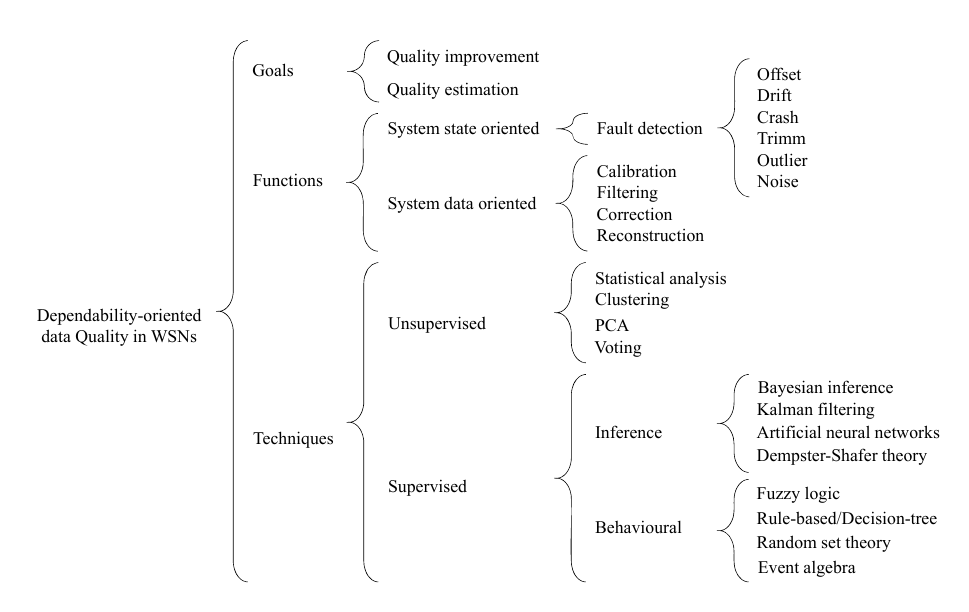
Figure 4. Schema of the categories of solutions for dependable